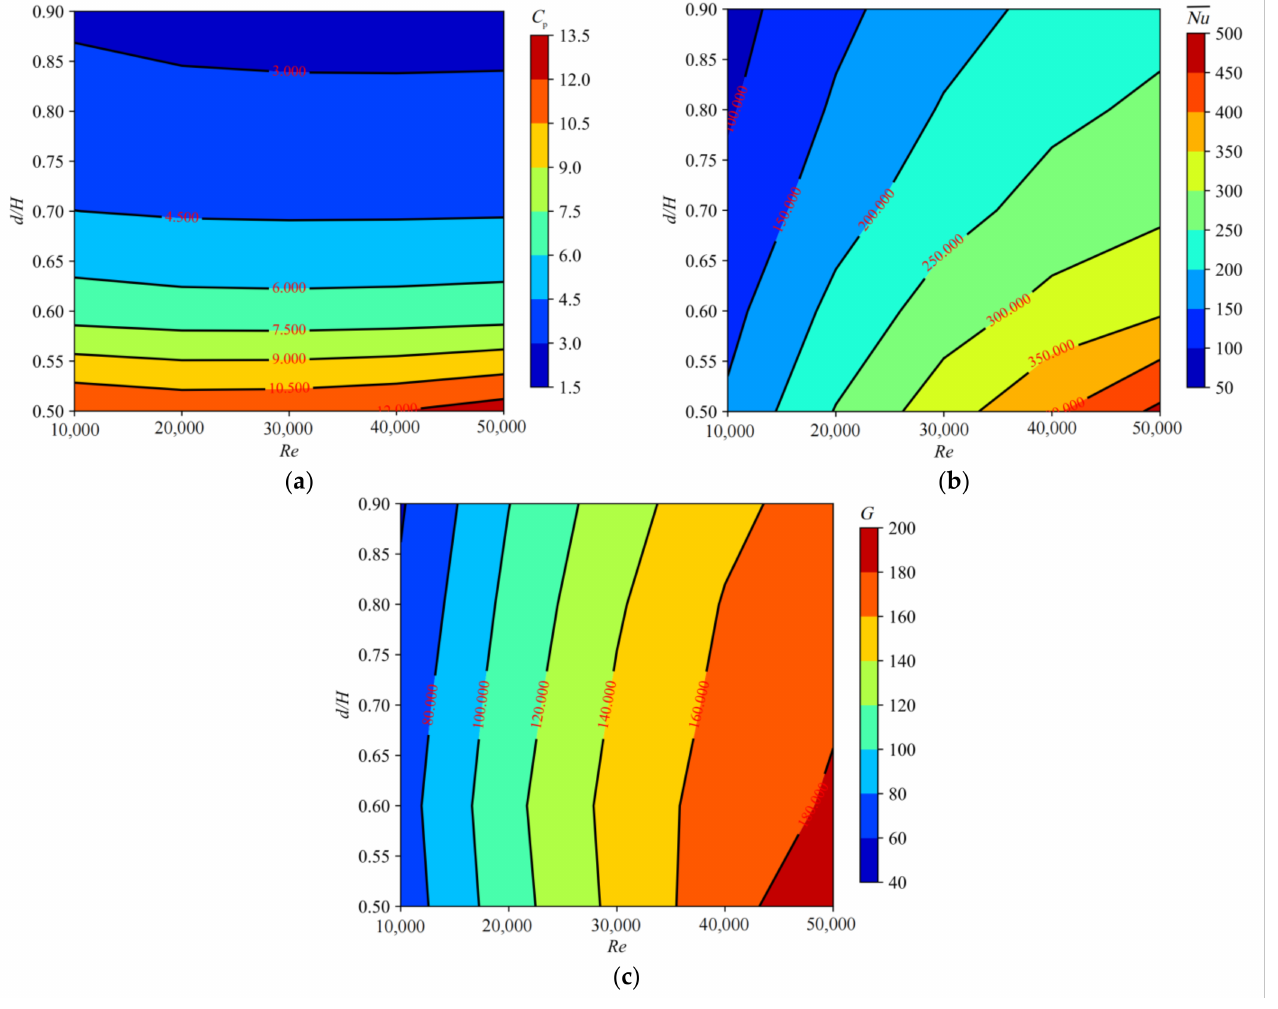
Figure 10. Effects of d/H on the pressure loss coefficient, average Nusselt number, and comprehensive thermal coefficient of the quasi-leading-edge channel under steam cooling: ( a ) pressure loss coefficient; ( b ) average Nusselt number; ( c ) comprehensive thermal